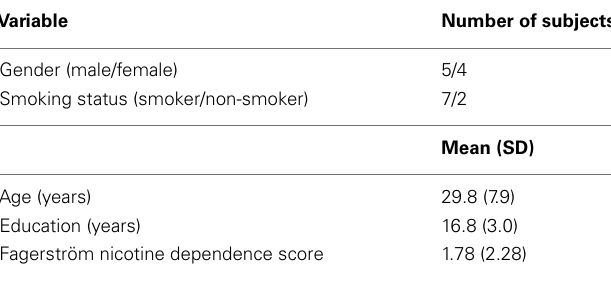
Table 1 | Demographic data for study completers ( N = 9)